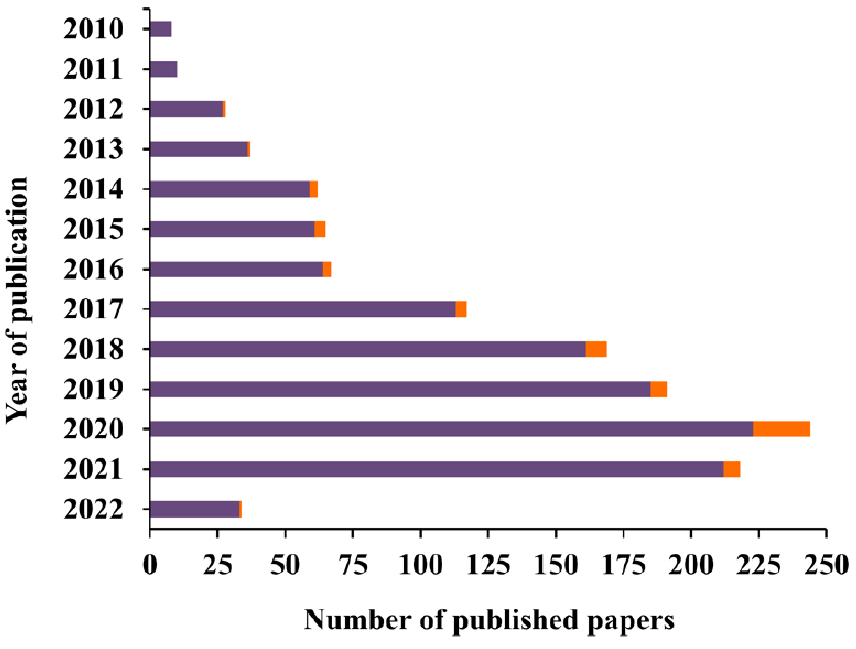
Figure 3. Number of published papers by year of publication. Data obtained from ISI WEB OF KNOWLEDGE with the keywords “colorimetric AND paper-based” (purple bar) and “colorimetric AND paper-based AND cancer” (orange bar). Data collected in March 2022.